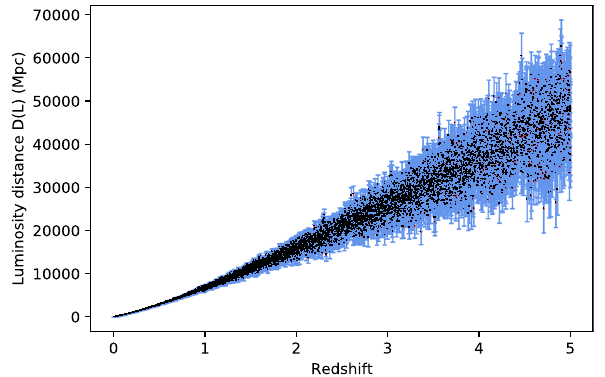
Fig. 1 The scatter plot of the luminosity distances in the catalog of 10,000 simulated GW events detectable by the DECIGO